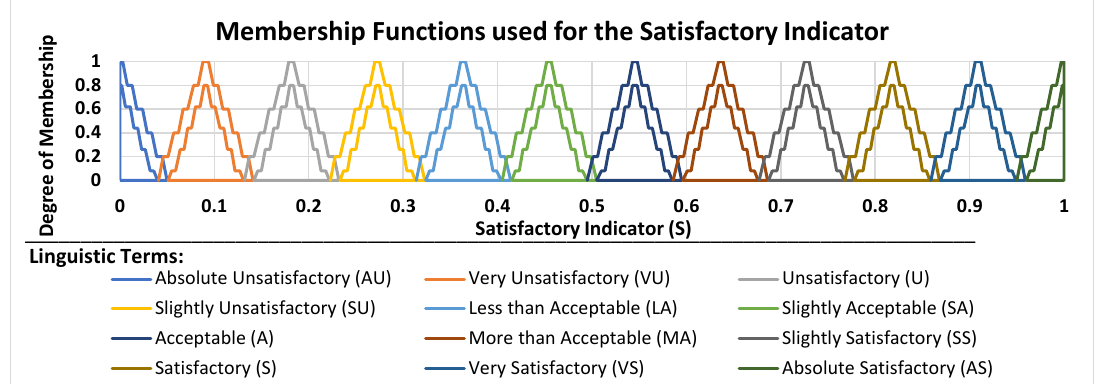
Figure 5. The membership functions used for the representation of the Quality indicator.